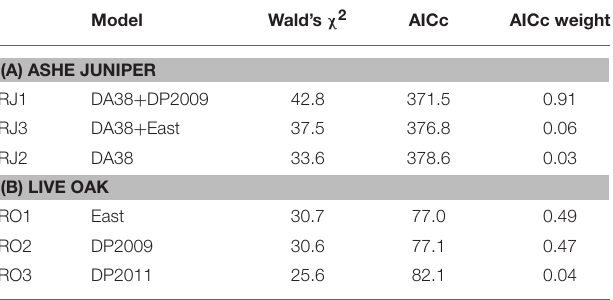
TABLE 6 | The three top regression models for incidence of resprouting among trees with 100% crown